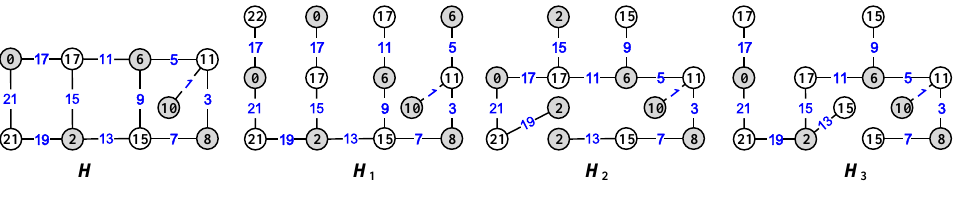
Figure 1. A set-ordered odd-graceful topological public key H and its own topological private keys H 1 , H 2 , H 3